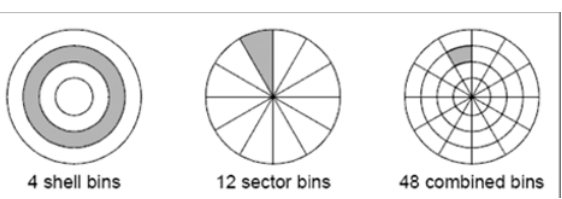
Figure 1. Examples of space decompositions for shape histograms, a single exemplary bin is marked in each case [7].